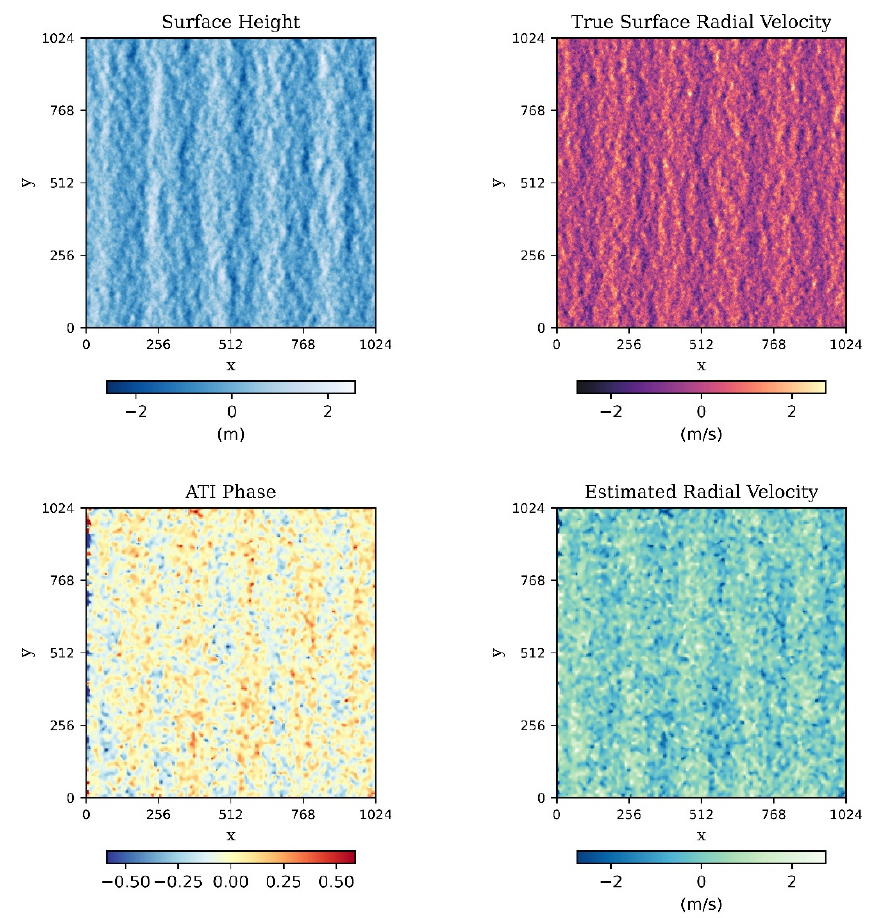
Figure 2. An example of the results of the ocean surface scattering simulations. It includes surface height, true surface radial velocity, the ATI phase for VV polarization, and the estimated radial velocity for VV polarization. In this case, current speed was set to 0.5 m/s, wind speed was 10 m/s, wind direction was 0°, and swell amplitude was 0.5 m.